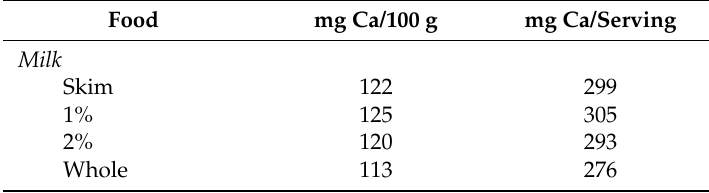
Table 2. Calcium content of dairy products and dairy substitutes